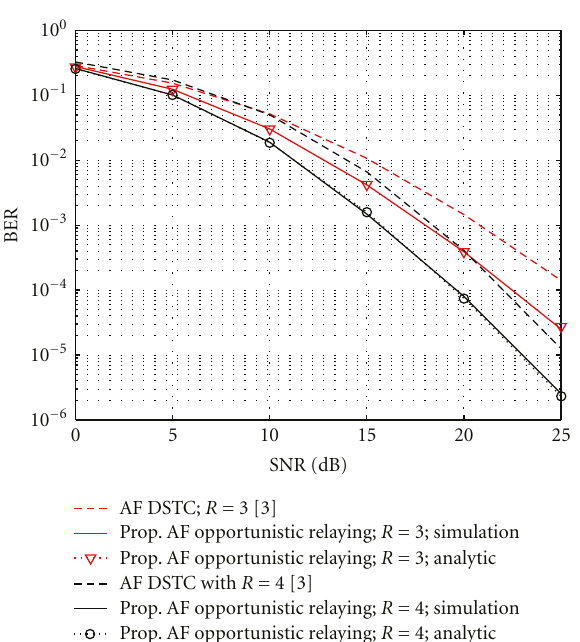
Figure 3: The average BER curves of relay networks employing DSTC and opportunistic relaying with partial statistical CSI at = σ 2 = 1. relays, BPSK signals and σ 2 g i f i